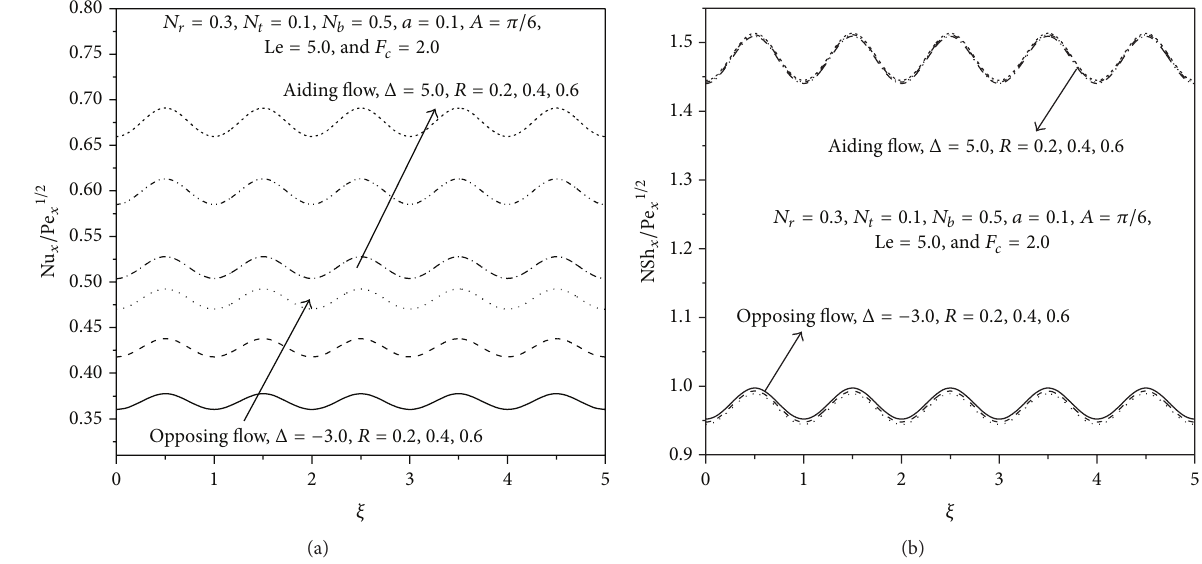
Figure 11: Effect of the radiation parameter ( 𝑅 ) on the heat and nanoparticle mass transfer